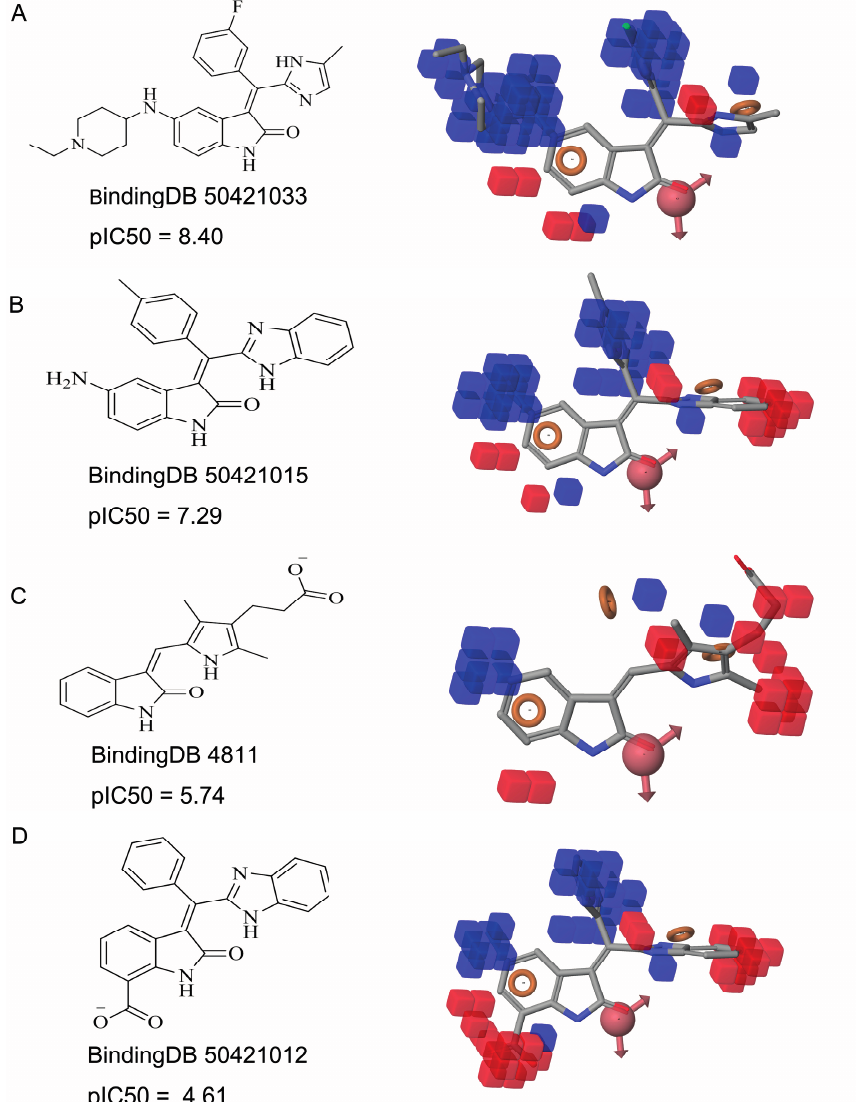
Figure 4. The QSAR model visualized in the context of the most active ( A ); moderately active ( B , C ); and the least active ( D ) molecules in training